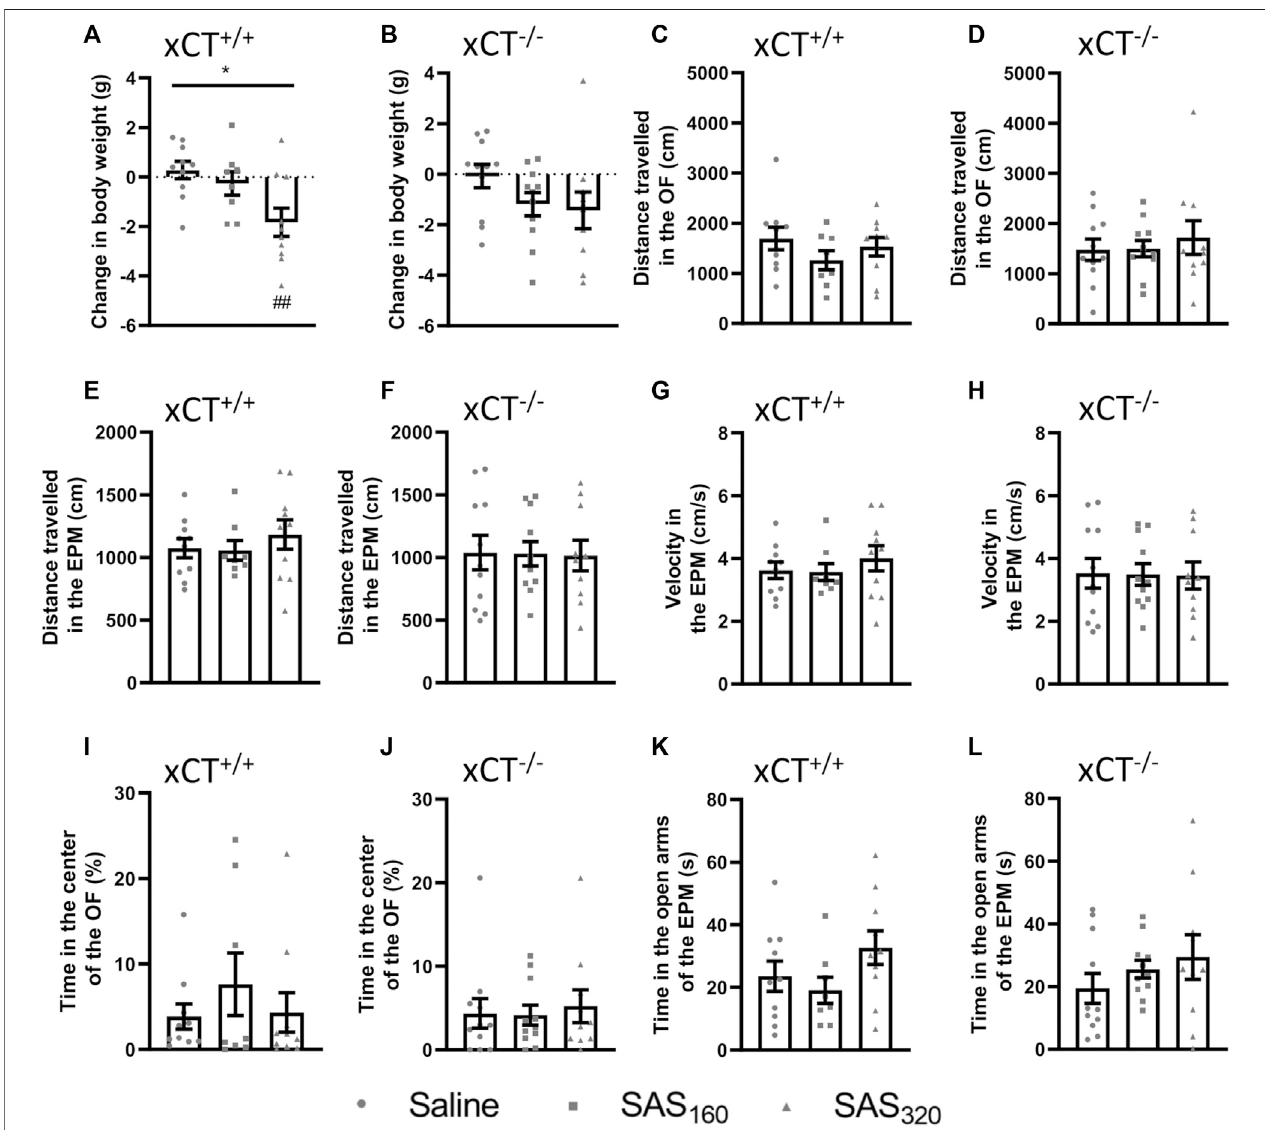
FIGURE 5 | Long-term effects of chronic sulfasalazine (SAS) treatment. After a wash-out period of one week, body weight of xCT +/+ (A) and xCT − / − mice (B) was evaluated and plotted as the change compared to baseline (i.e. bodyweight at the start of the treatment). Distance travelled in the open fi eld (OF) arena (C,D) or the elevated plus maze (EPM) (E,F) , and velocity while exploring the EPM (G,H) were evaluated and represent long-term effects on locomotor function. Time spent in the center of the OF (I, J) or in the open arms of the EPM (K,L) was used as a parameter for anxiety-like behavior. For all tests, n (cid:2) 8 – 10 xCT +/+ mice/group and n (cid:2) 10 – 11xCT − / − mice/group wereused. Dataare presented asmean ± SEMand analyzed using aKruskal-Wallis test (* p < 0.05) followed byDunn ’ s multiple comparisons for each dose of SAS compared to saline ( ## p <